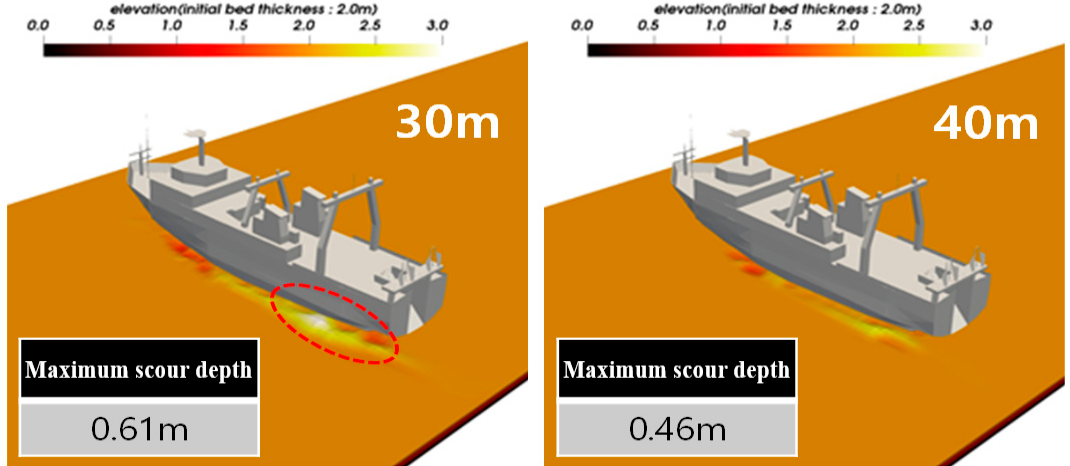
Figure 7. Sectional scouring patterns at the side of the sunken vessel artificial reef.